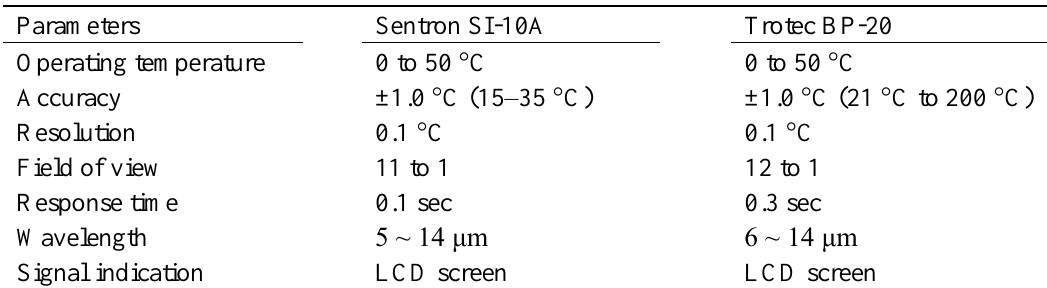
Table 1. Specifications of the thermopile infrared